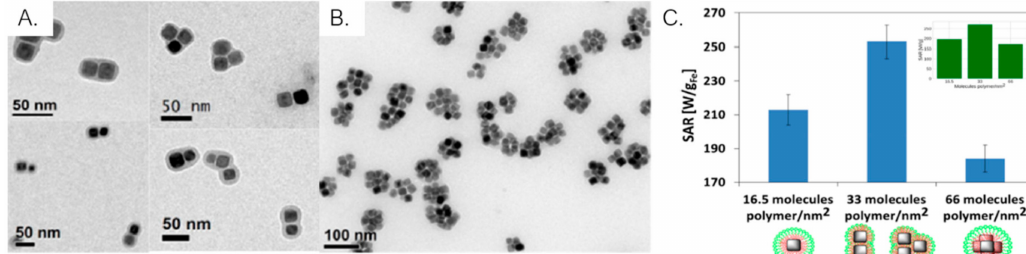
Figure 9. TEM images of dimer and trimer ( A ) and centrosymmetric (with more than 4 nanocubes) ( B ) iron oxide nanoclusters; ( C ) SAR values of the di ff erent nanoassemblies shows that dimer and trimer structures have the highest SAR values. Adapted from [158] with permission from American Chemical Society